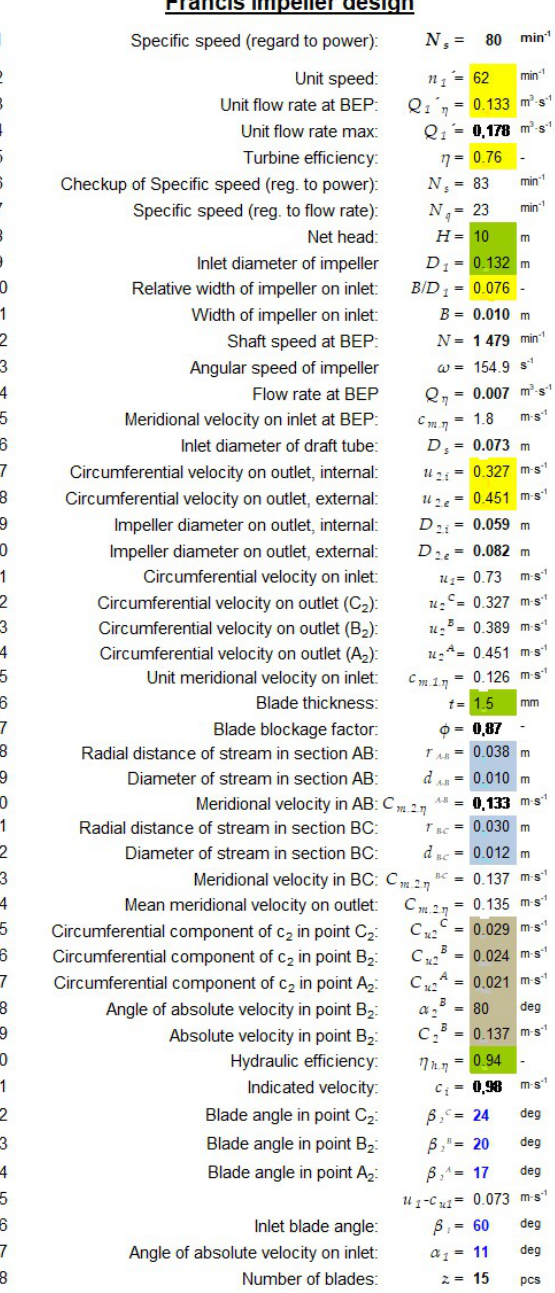
Figure 5. Calculation protocol of the Francis impeller design based on